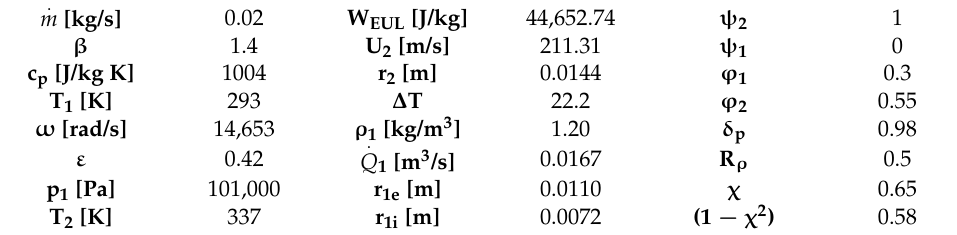
Figure 2. Typical channel shapes as a function of flow coefficient. Table 1. Designed compressor specifications.